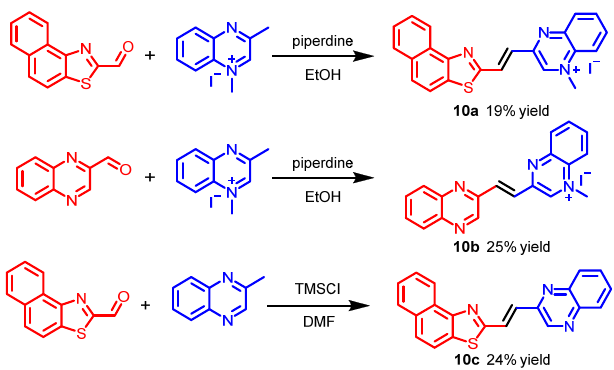
Molecules 2023 , 28 , x 10 of 38 Figure 9. Confocal fluorescence images of various cell lines (HeLa, HepG2, and HUVEC cells) stained with cyanine dye 9b , the mitochondria indicator MitoTracker Green, and the nucleus indi- cator Hoechst 33,342. Adapted from [31]. In 2022, Ge’s group reported two hemi-cyanine probes, 10a and 10b , and a neutral